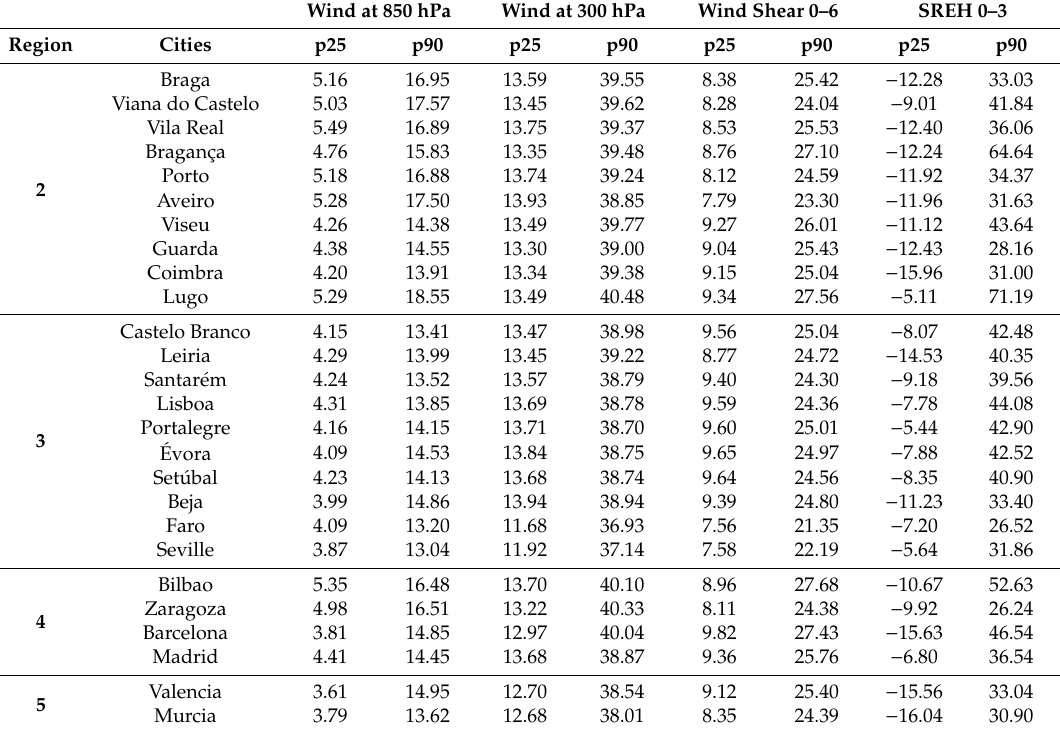
Table A2. Table of percentile 25 and 90 based on the annual mean intensity values for wind speed at 850 and 300 hPa, wind shear (0–6) and SREH